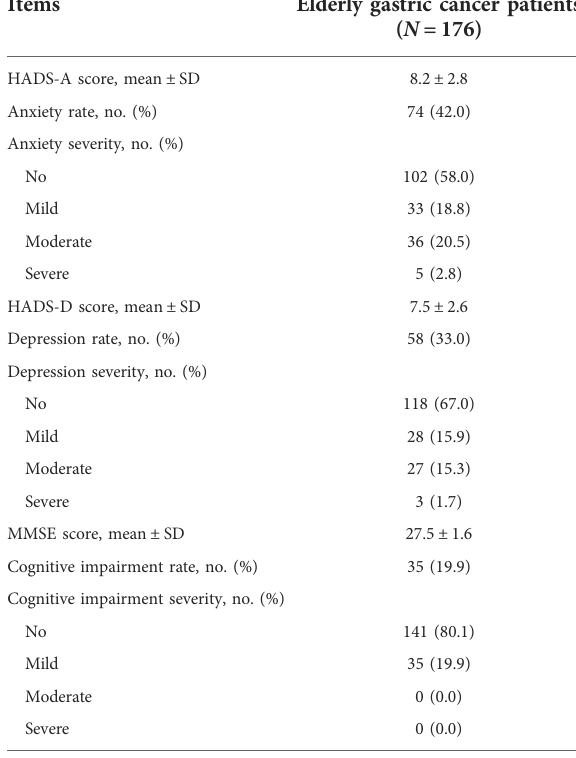
TABLE 2 Anxiety, depression, and cognitive impairment.